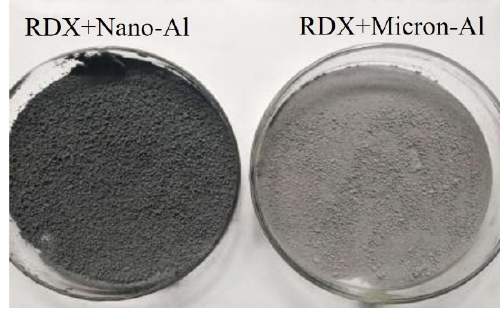
Figure 2. Photography of RDX with Nano-Al and Micron-Al.